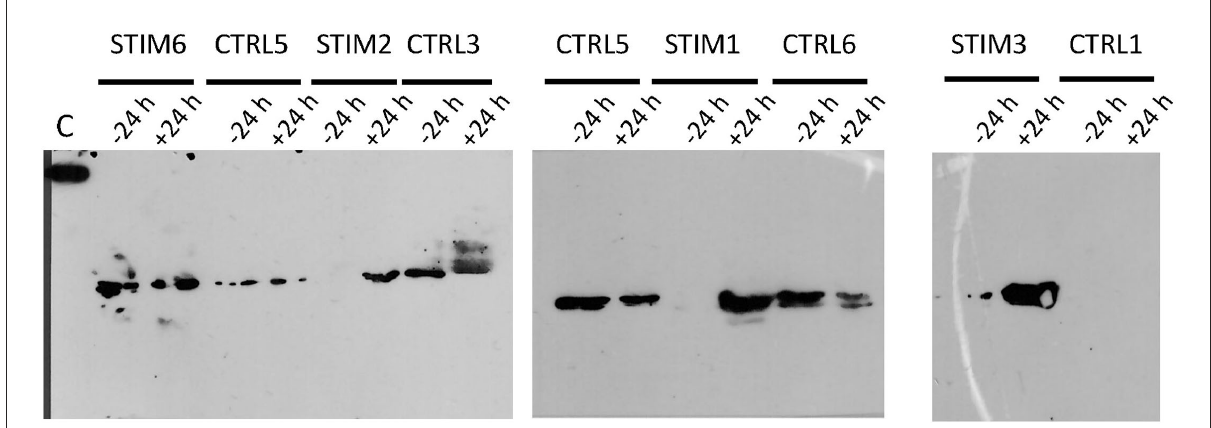
FIGURE6 Immunodetection of O -GlcNAcylated proteins by western-blot with CTD110.6 antibody in olfactory secretome of ewes, stimulated or not by male. Sample times ( − 24h and + 24h) frame the time of male introduction (T0). C, control; 5 ng of